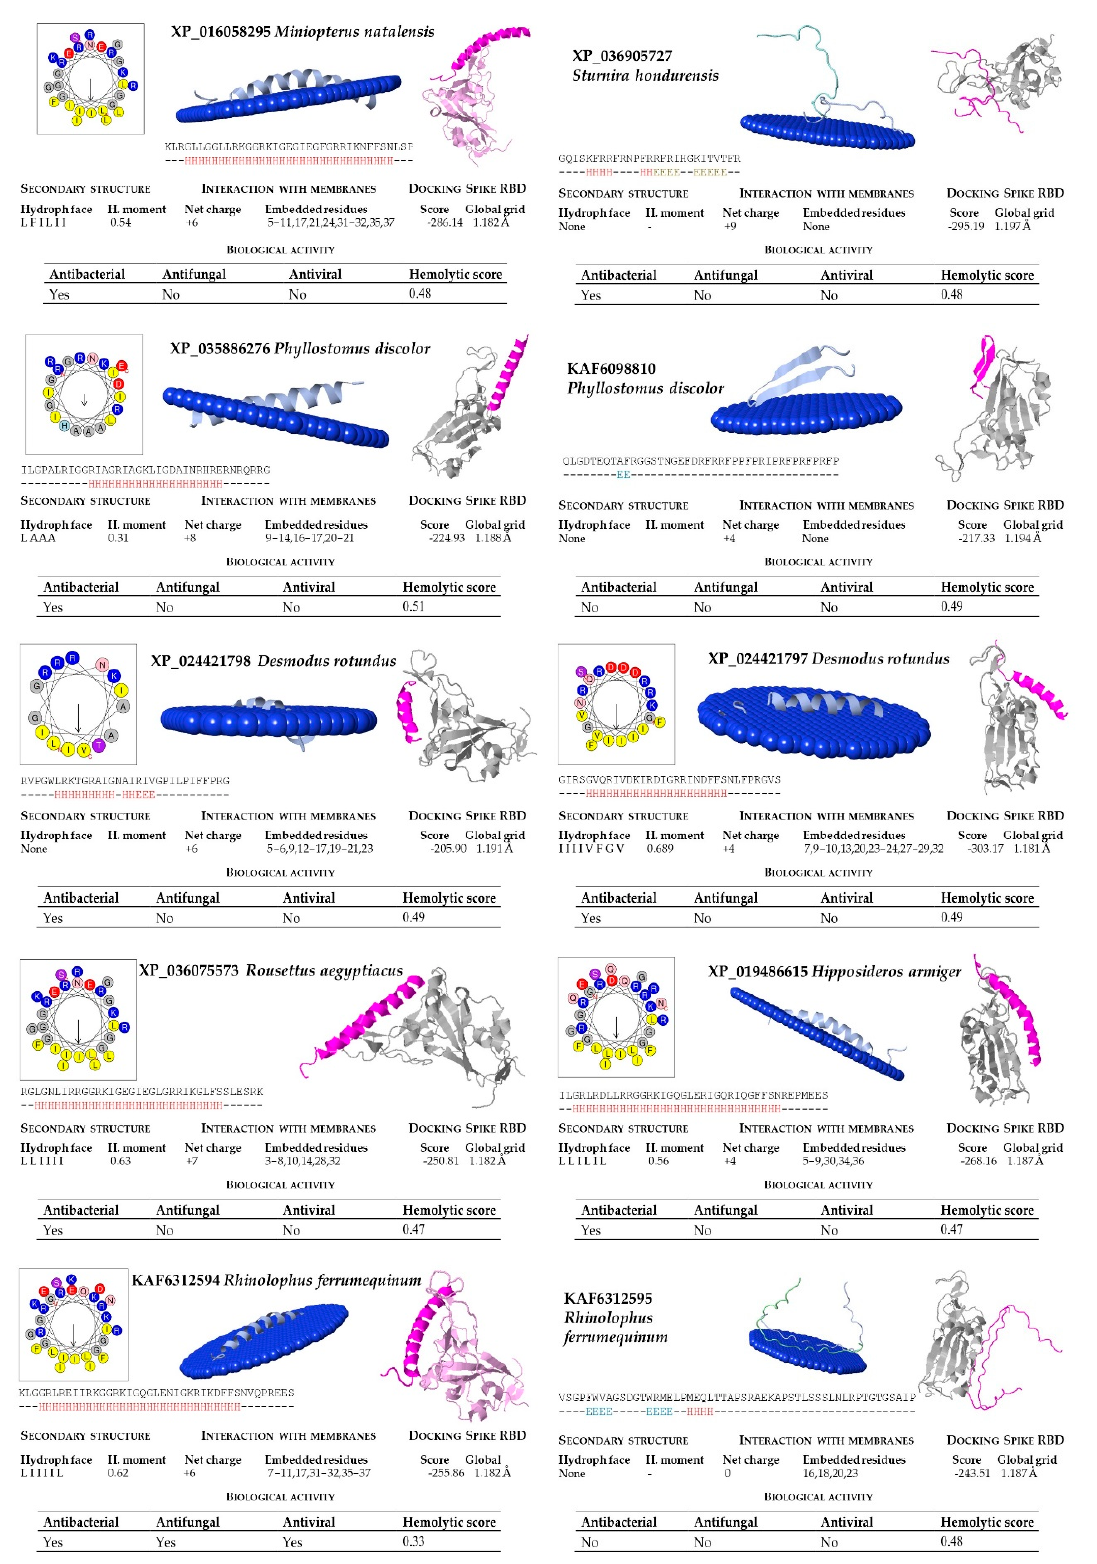
Figure 4. Bioinformatic analysis of bat cathelicidins (part 1). Net charge, secondary structure, hydrophobicity of helixes, and interaction with membranes and SARS-CoV-2 region binding domain (RBD) of the Spike protein were computed. The analysis includes predictions of biological properties of the peptides, such as antibacterial, antifungal, antiviral, and hemolytic